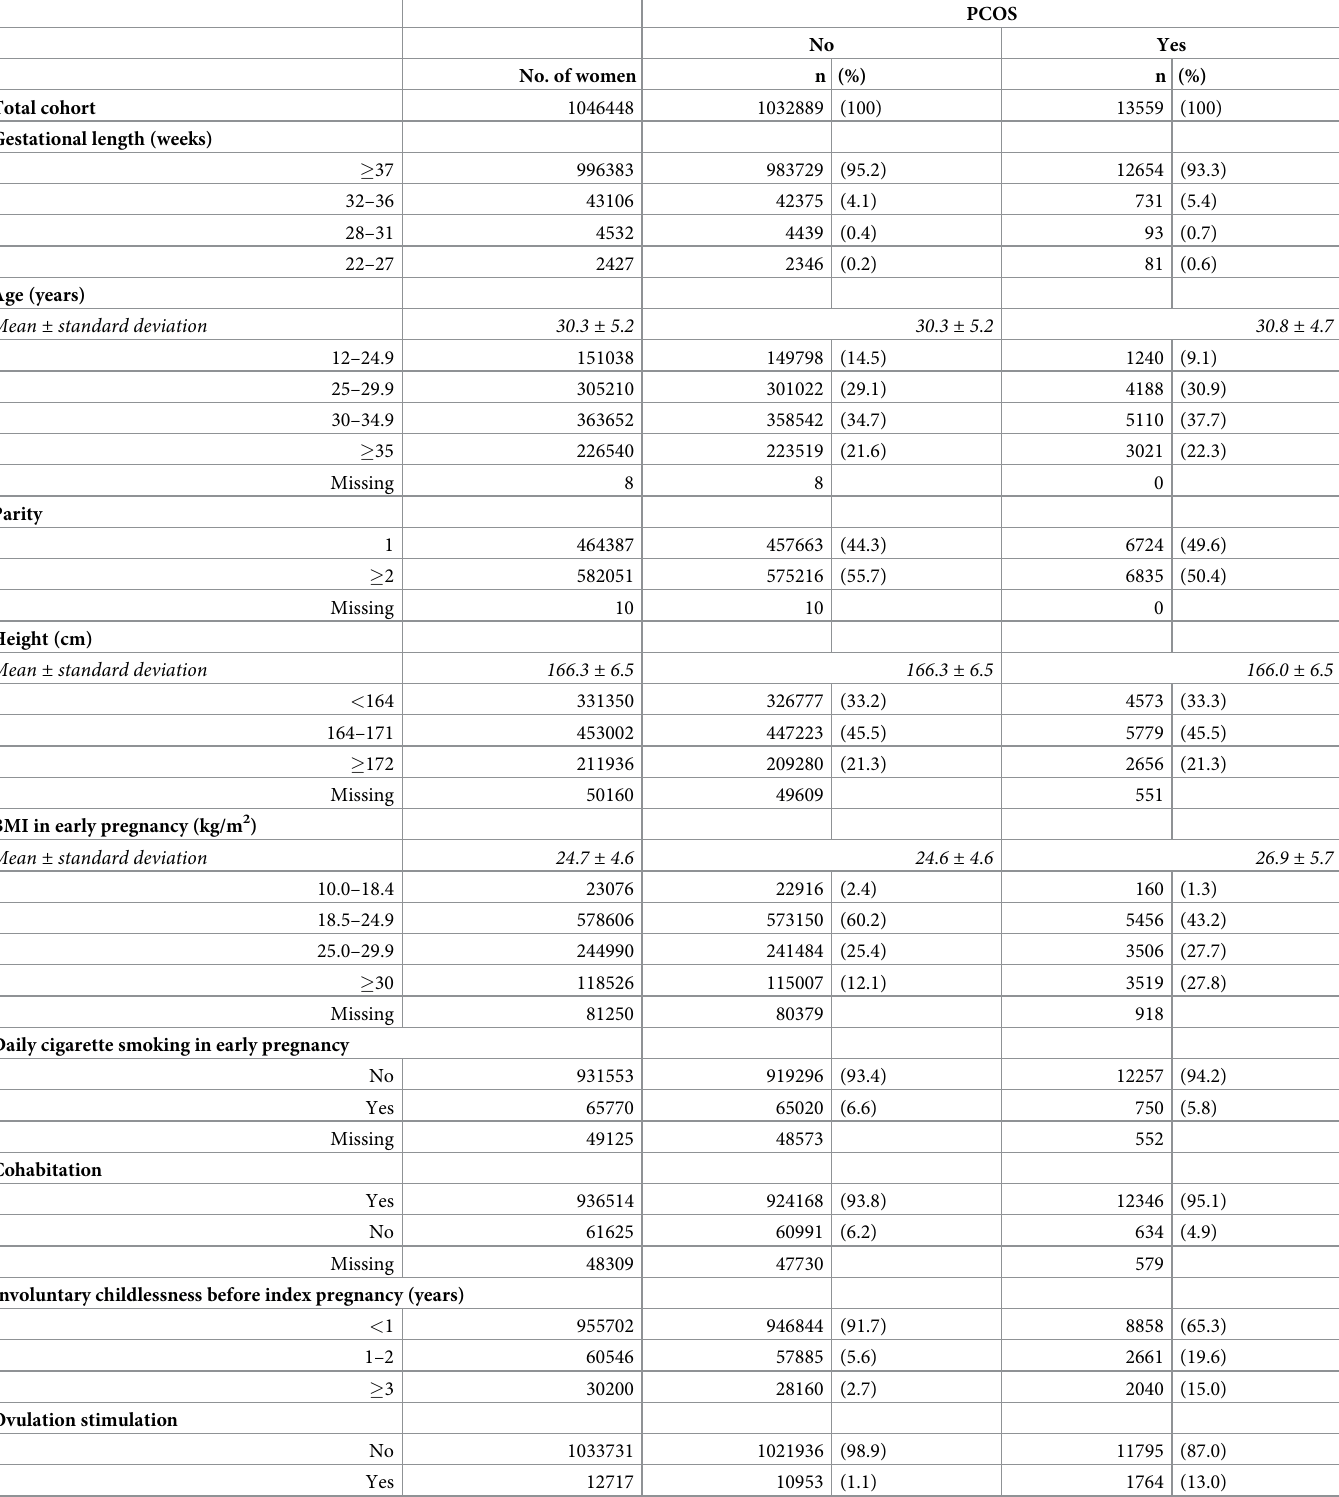
Table 1. Maternal characteristics in PCOS women giving birth in Sweden